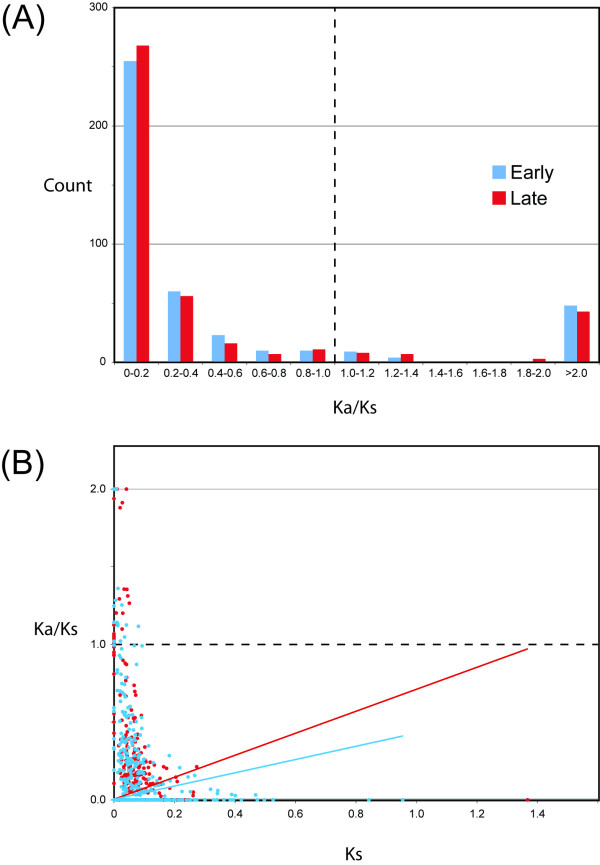
Functional constraints are similar in early and later stages of duplicate gene evolution in X. laevis paralogs. (A) Binned Ka/Ks of early (blue) and later (red) stages of duplicate gene evolution. (B) Regression of Ka/Ks versus Ks in the early and later stages indicates that selection (relaxed purifying + positive) is not more common in the early stage of duplicate gene evolution (blue dots) than the later stage (red dots). The Y-intercept of these regression lines was set to zero and Ka/Ks ratios greater 2 (including undefined ratios) were given a value of 2. In (A) and (B), a dashed line indicates the neutral expectation. Fragments with Ka/Ks > 2 are, on average, half of the size of those with Ka/Ks < 2. Ka/Ks ratios above 2 may therefore be attributable in part to stochastic variance in Ks [43].